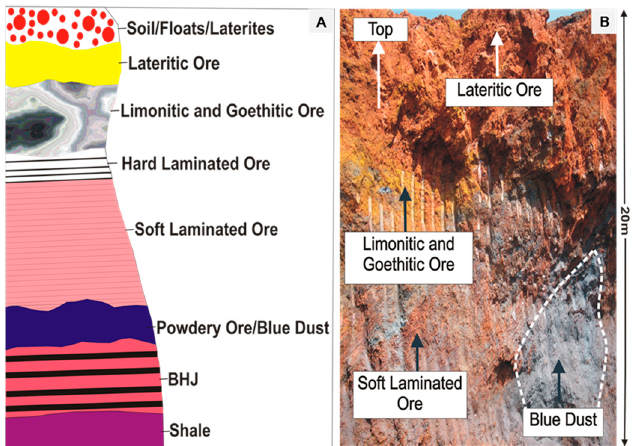
conglomerate exposed along the Karo River.